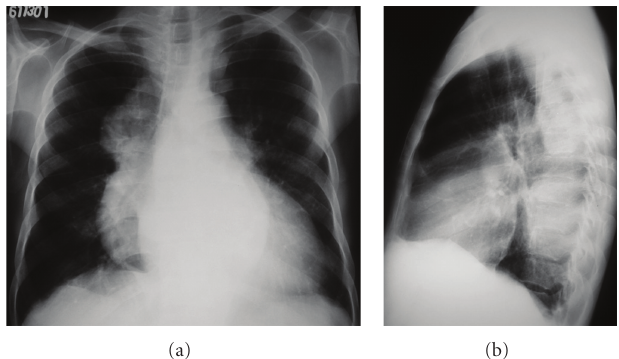
Figure 1: Anteroposterior (a) and lateral (b) chest radiographs showing large lobulated bilateral masses located in the retrocardiac region.